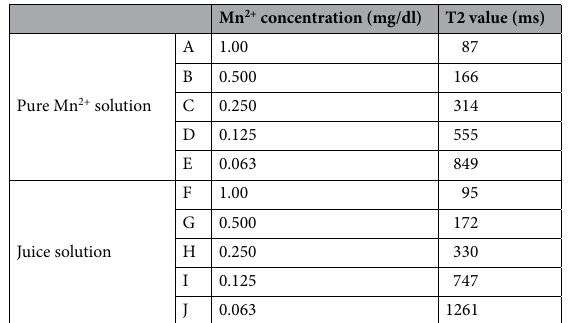
Table 1. Different dilutions of pure Mn 2+ solutions and natural pineapple